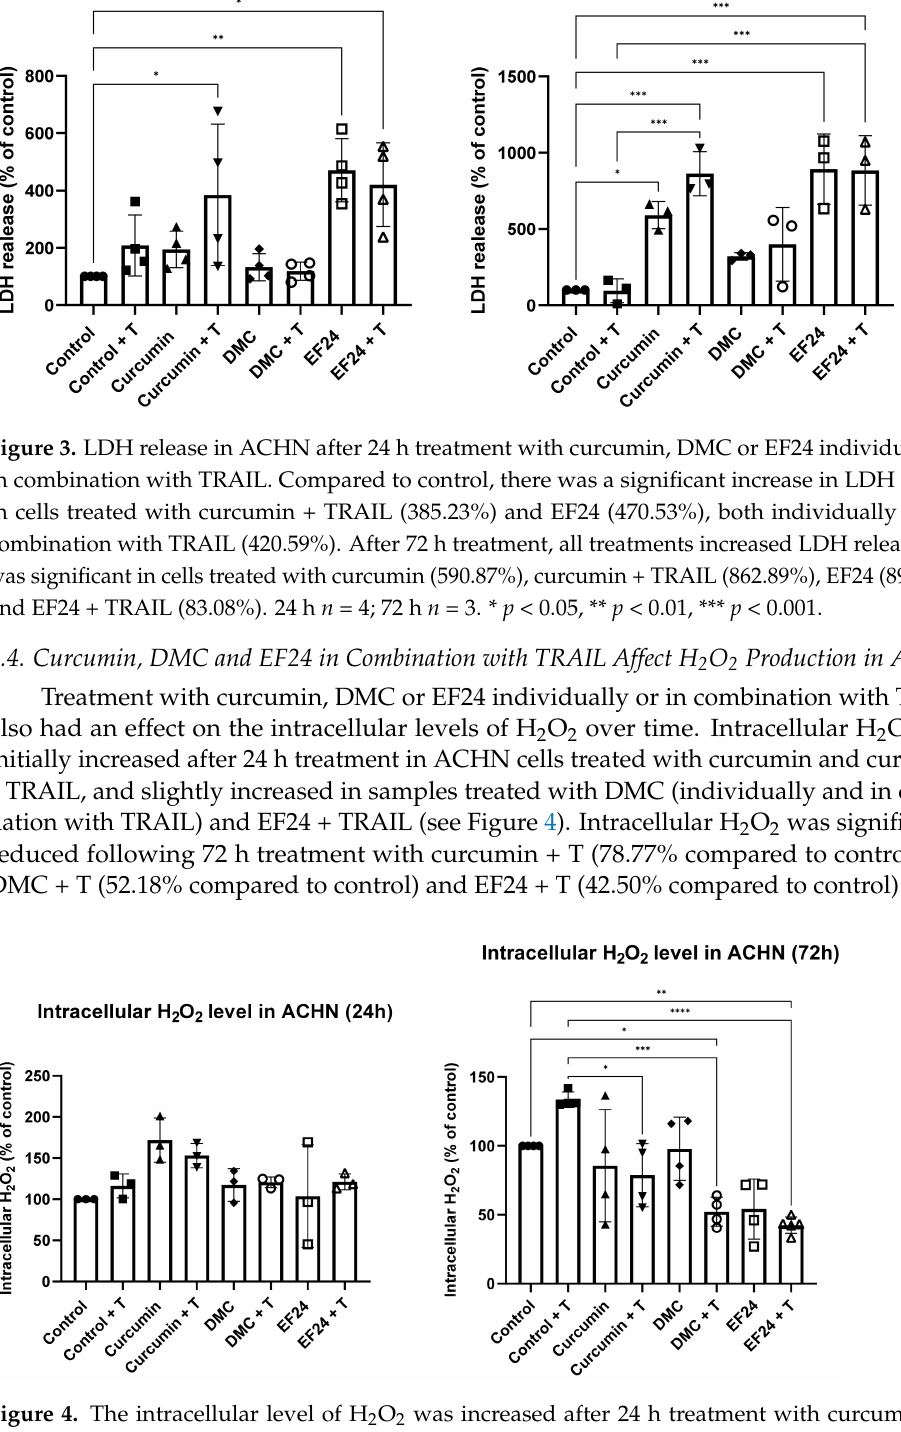
Figure 4. The intracellular level of H 2 O 2 was increased after 24 h treatment with curcumin and curcumin + TRAIL; however, this increase was not significant. After 72 h treatment, intracellular H 2 O 2 was decreased following treatment with curcumin, DMC and EF24 individually or in combination with TRAIL. This decrease was significant in DMC + T (52.18%) and EF24 + T (42.50%) treated ACHNs (compared to vehicle control), and the significance was increased when comparing the samples to the TRAIL-treated ACHNs, in which case all combination treatments showed significance. All samples were normalized to protein concentration and to vehicle control, 24 h n = 3; 72 h n = 4. * p < 0.05, ** p < 0.01, *** p < 0.001, **** p <